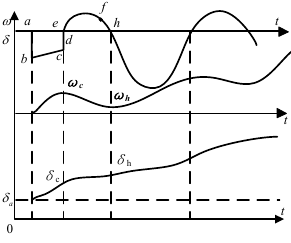
Figure 5. Out-of-step Figure 5. Out ‐ of ‐ step process.